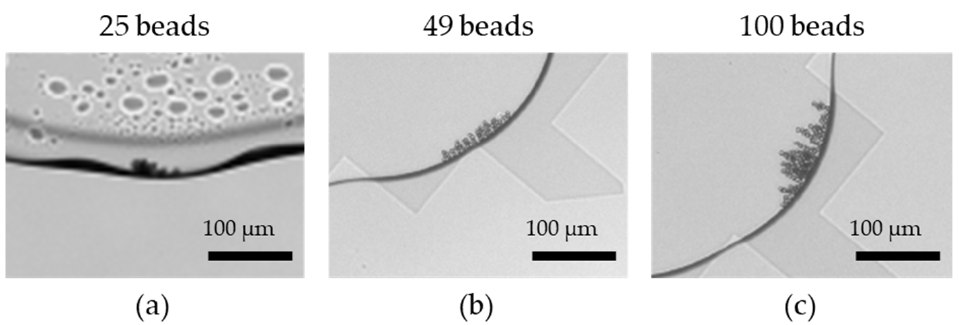
Figure 7. Microscopic images of successful aggregation at bead numbers of ( a ) 25, ( b ) 49, and ( c ) 100.